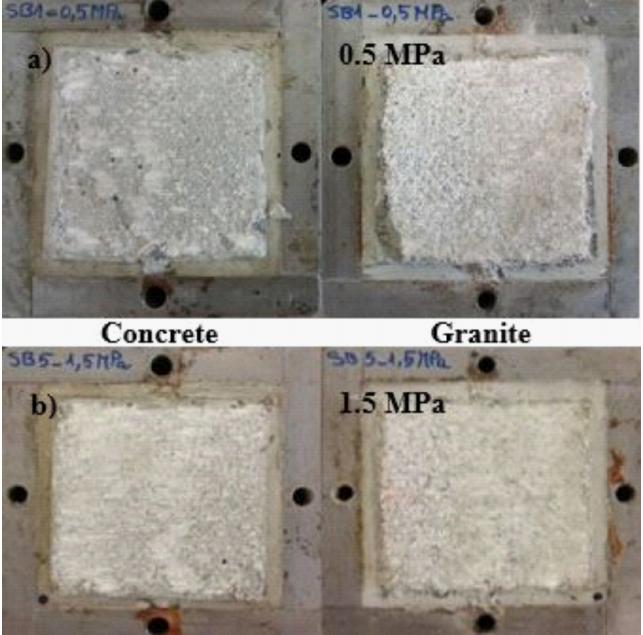
Figure 7. Failure behaviors—bush-hammered interfaces. ( a ) Confinement stress 0.5 MPa: left- Concrete and right Granite; ( b ) Confinement stress 1.5 MPa: left-Concrete and right